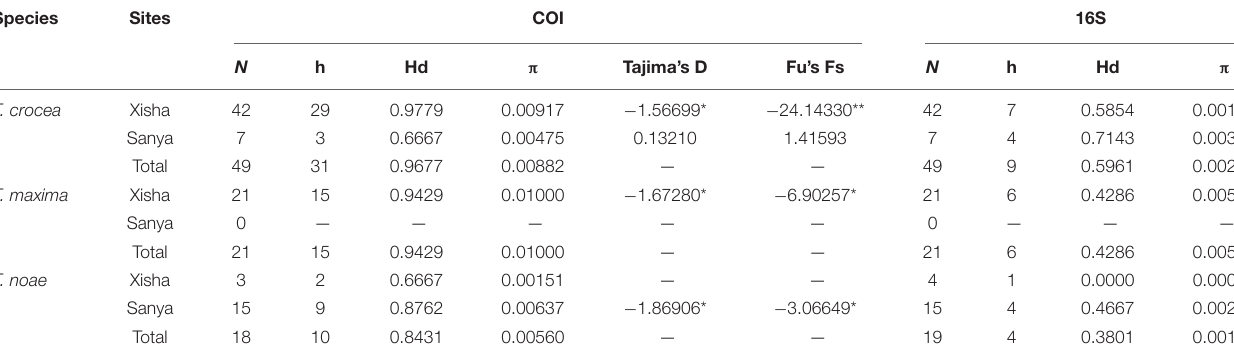
TABLE 2 | Genetic diversity of the COI and 16S among different species and sites, and COI neutrality tests. Species Sites COI 16S